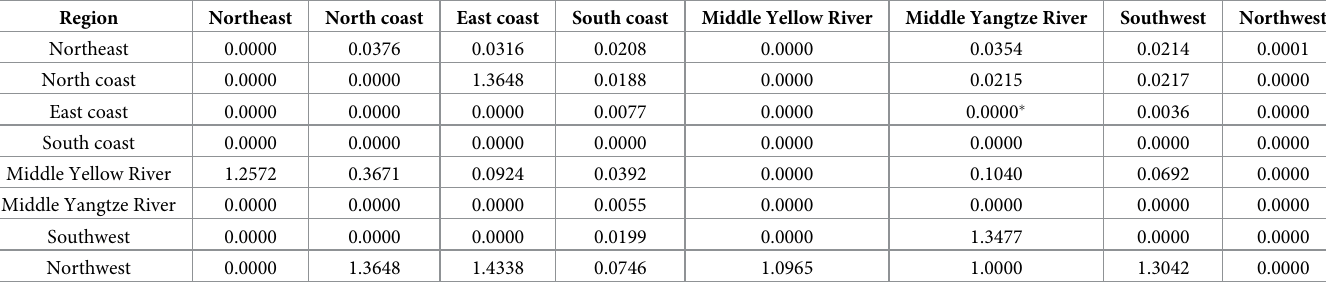
Table 7. The matching degree of embodied carbon trade and value-added trade among the eight regions in 2015. Region Northeast